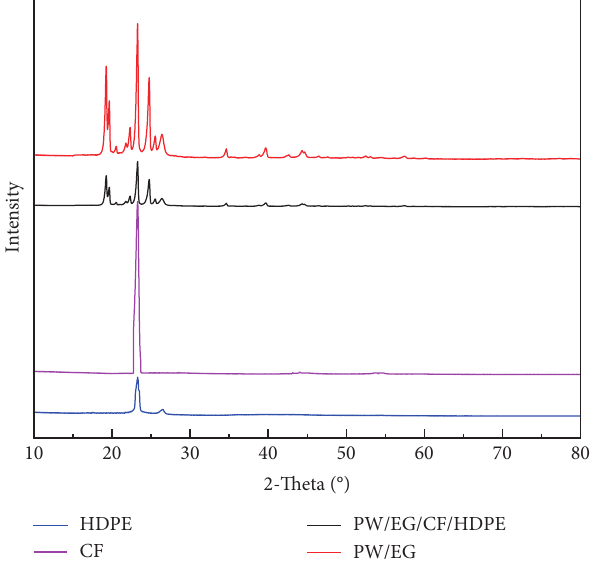
Figure 8: XRD curves of the HDPE, CF, PW/EG, and PW/EG/CF/HDPE.